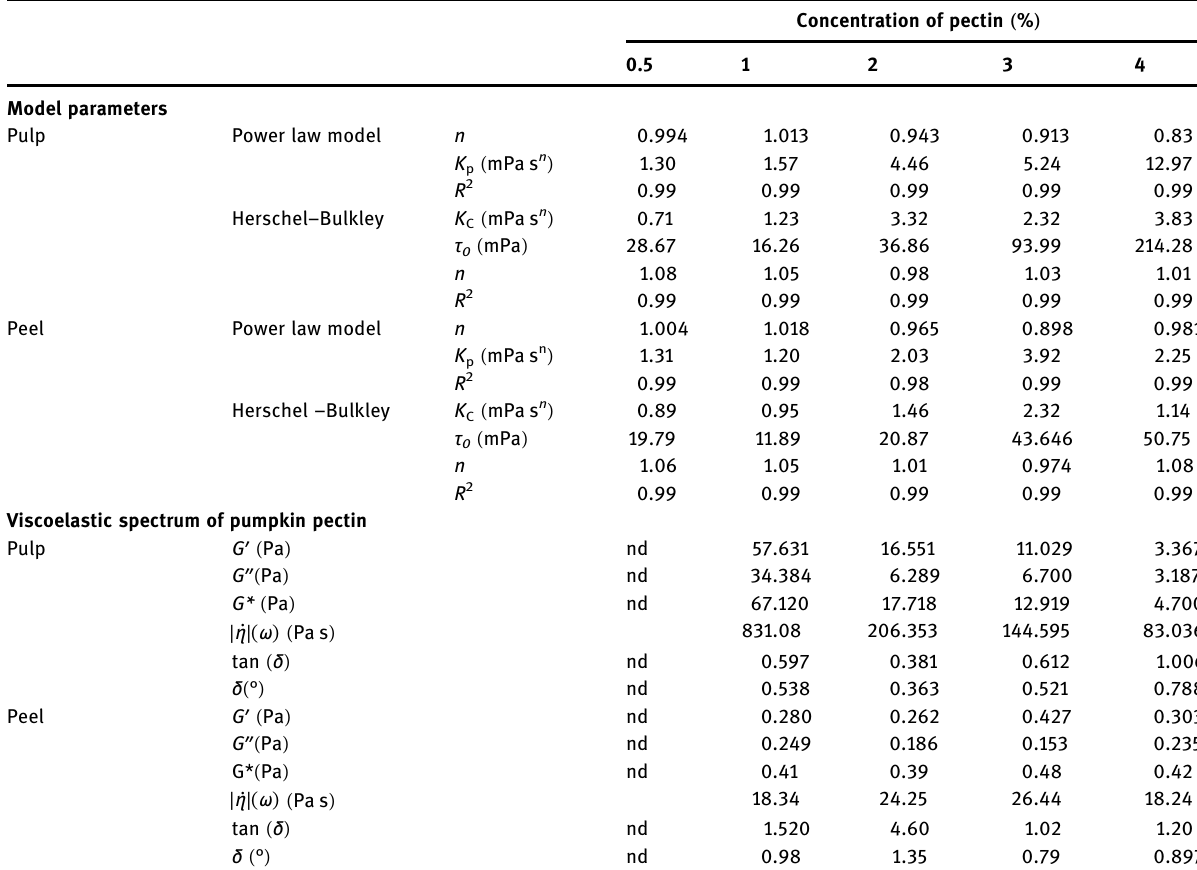
Table 4: Rheological properties of aqueous solutions of pumpkin pectin extracted from pulp and peel by water treatment at pH 1.8 after modeling of fl ow experimental data ( 20°C